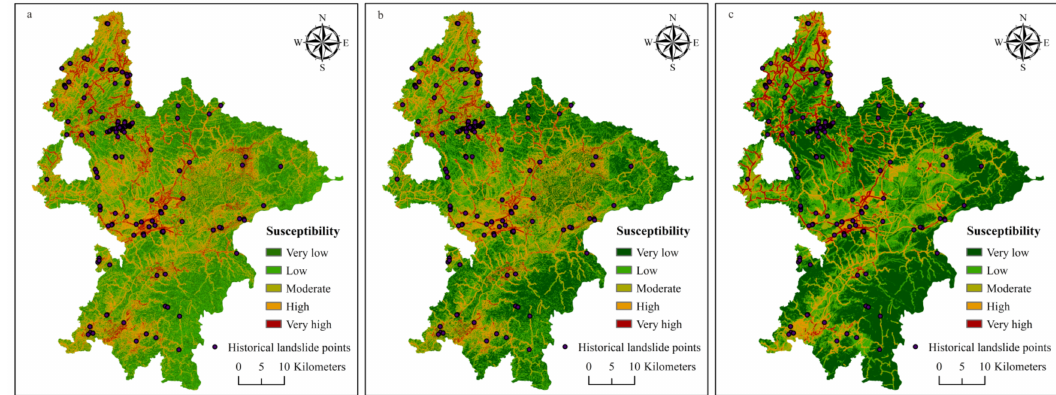
Figure 8. Landslide susceptibility zonation maps of Ruijin: ( a ) from the simple numeric labeling (SNL)-based RF modeling; ( b ) from the weight assignment (WA)-based RF modeling; and ( c ) from the frequency ratio (FR)-based RF